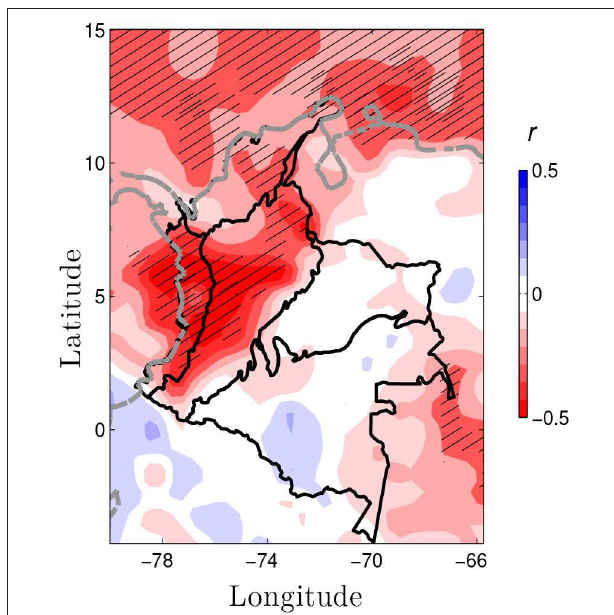
FIGURE 5 | Pearson correlation, r , between rainfall anomalies in Colombia and SST3.4 anomalies. (Dashed gray line) Northern South American coast line. (Black line) Borders denote Colombia’s natural regions. The hatched areas indicate that r is significant at 5%. The significance levels are calculated considering the Effective Degrees of Freedom due to autocorrelation in timeseries [